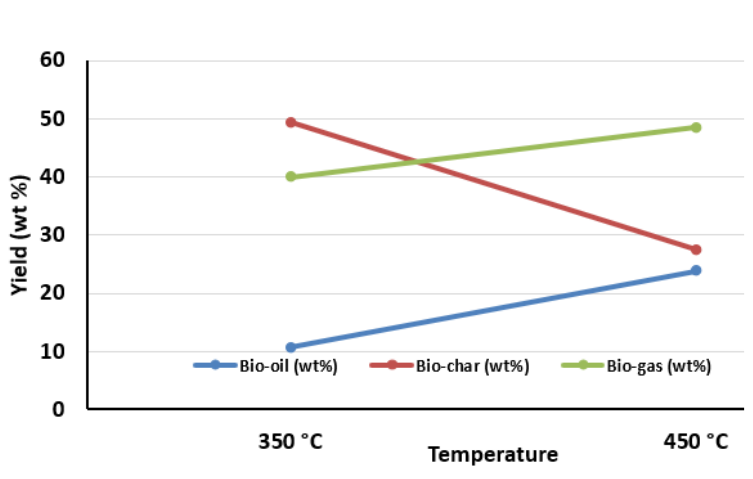
Figure 6: Bio-oil yield for microwave-assisted hydrothermal in different